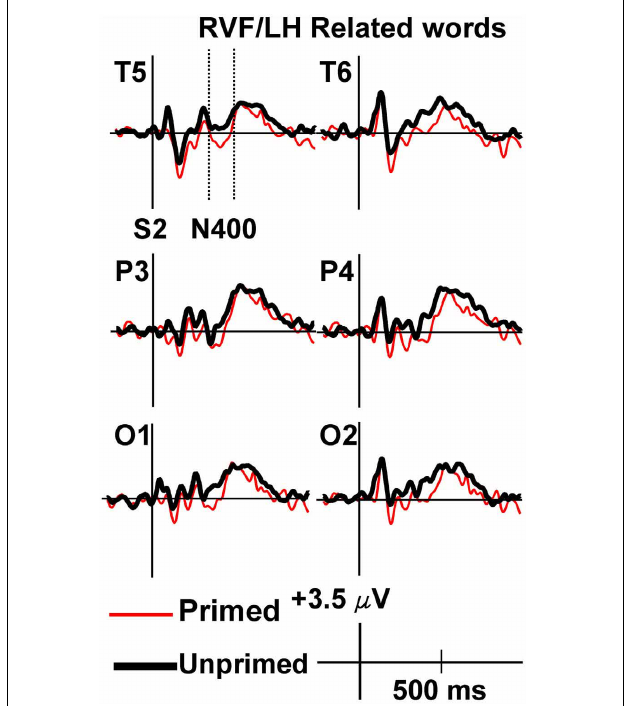
FIGURE 3 | Grand average ERPs recorded to non-synonymously related targets presented to the RVF/LH. Non-synonymously related words produced more negative N400s than unrelated words (i.e., demonstrating